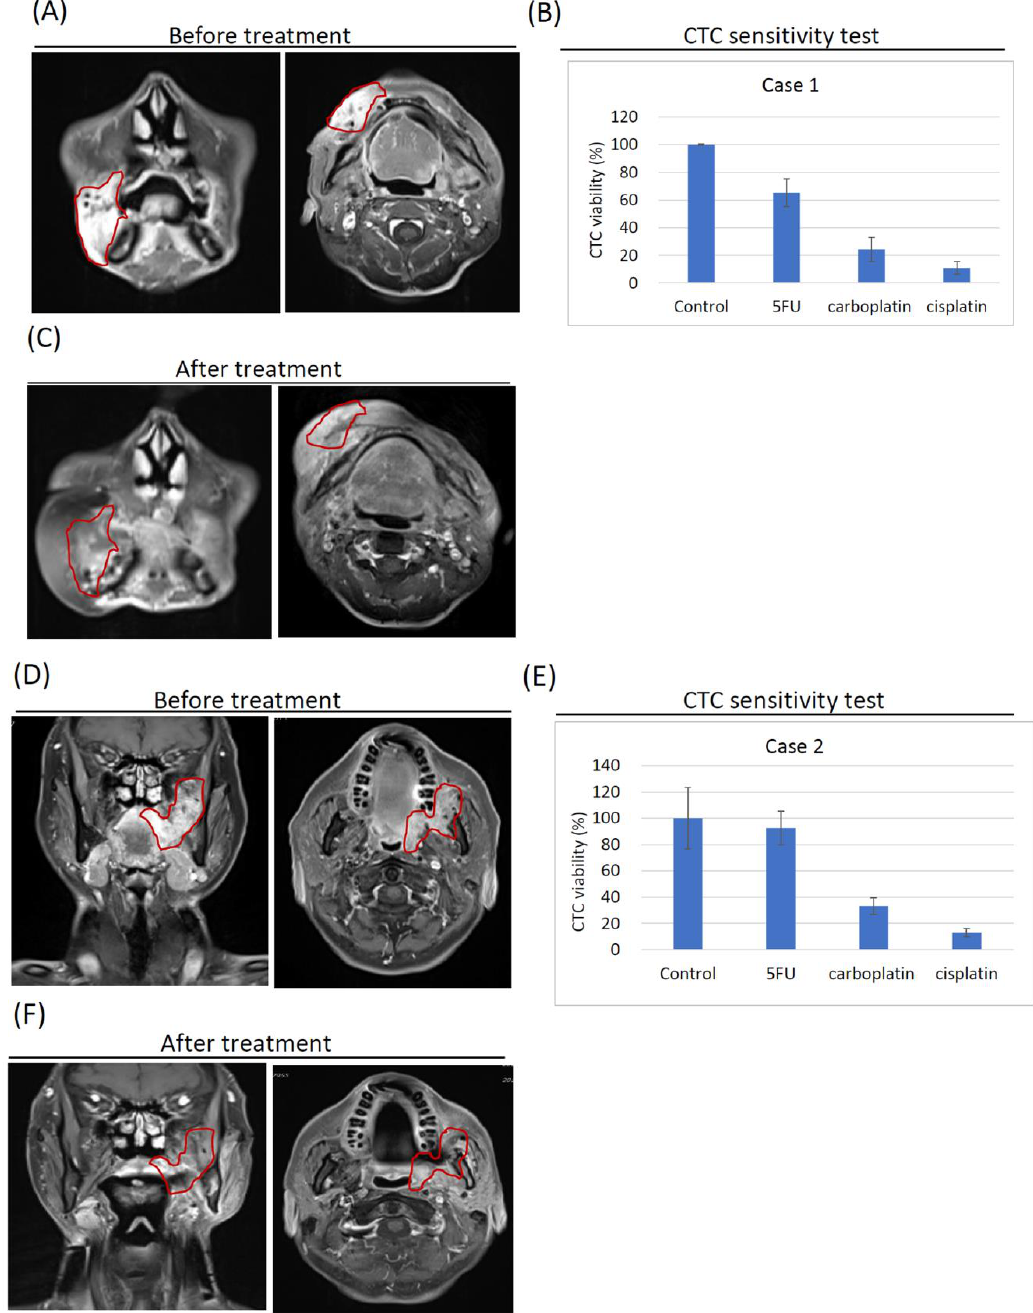
Figure 3. Magnetic resonance imaging (MRI) and eSelect relative cell viability of two illustrative case studies. ( A ) MRI results at diagnosis for Case 1 indicating a raised lesion in the right buccal region with skin induration labelled as the red circle. ( B ) Relative cell viability of CTC-derived organoids treated with 5-FU, carboplatin, or cisplatin by using the eSelect system in Case 1, notably, cisplatin sensitivity was below 20%. ( C ) MRI results at 1 year after concurrent chemoradiation therapy (CCRT) following surgery and adjuvant CCRT with cisplatin and carboplatin for Case 1, red circle represented that complete response to treatment with no residual tumor or lymph node metastasis. ( D ) MRI results at diagnosis for Case 2, the red circle indicated an indurative lesion in the left buccal region that extended to the pterygomandibular space, lateral pharyngeal region, and infratemporal space. ( E ) Relative cell viability of CTC-derived organoids treated with 5-FU, carboplatin, or cisplatin using the eSelect system in Case 2; notably, cells viability was below 20% when exposed to cisplatin. ( F ) MRI results at 1 year after CCRT with cisplatin for Case 2, indicating complete response to treatment with no residual tumor or lymph node metastasis (red circle).